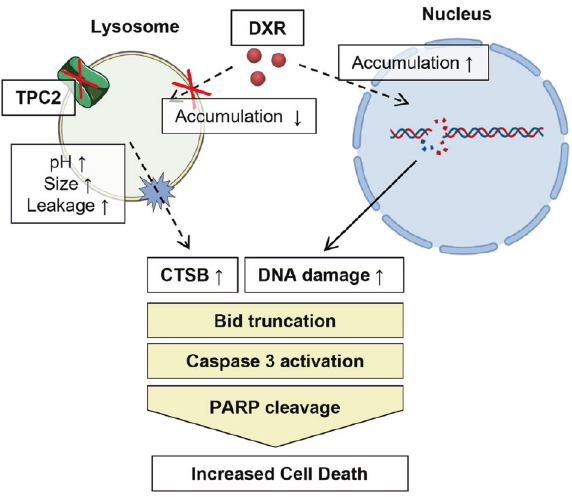
Fig. 6 Lysosomal leakage and cathepsins are involved in the increased sensitivity of TPC2 knockout cells. A Immunoblots of lysates containing lysosome-free cytosol of VCR-R CEM TPC2 wt and TPC2 ko cells. B Quantitative evaluation of protein levels from ( A ). C Cathepsin B